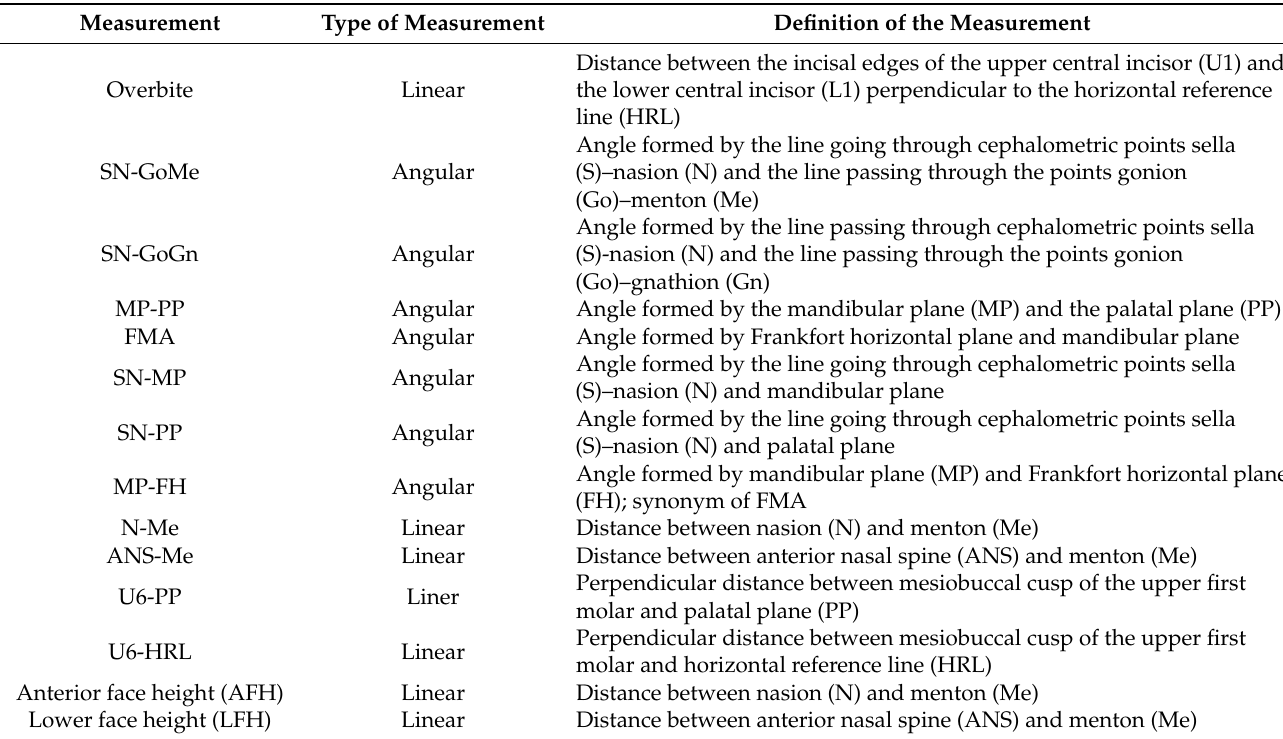
Table 7. Cephalometric measurements used in selected articles relevant to this